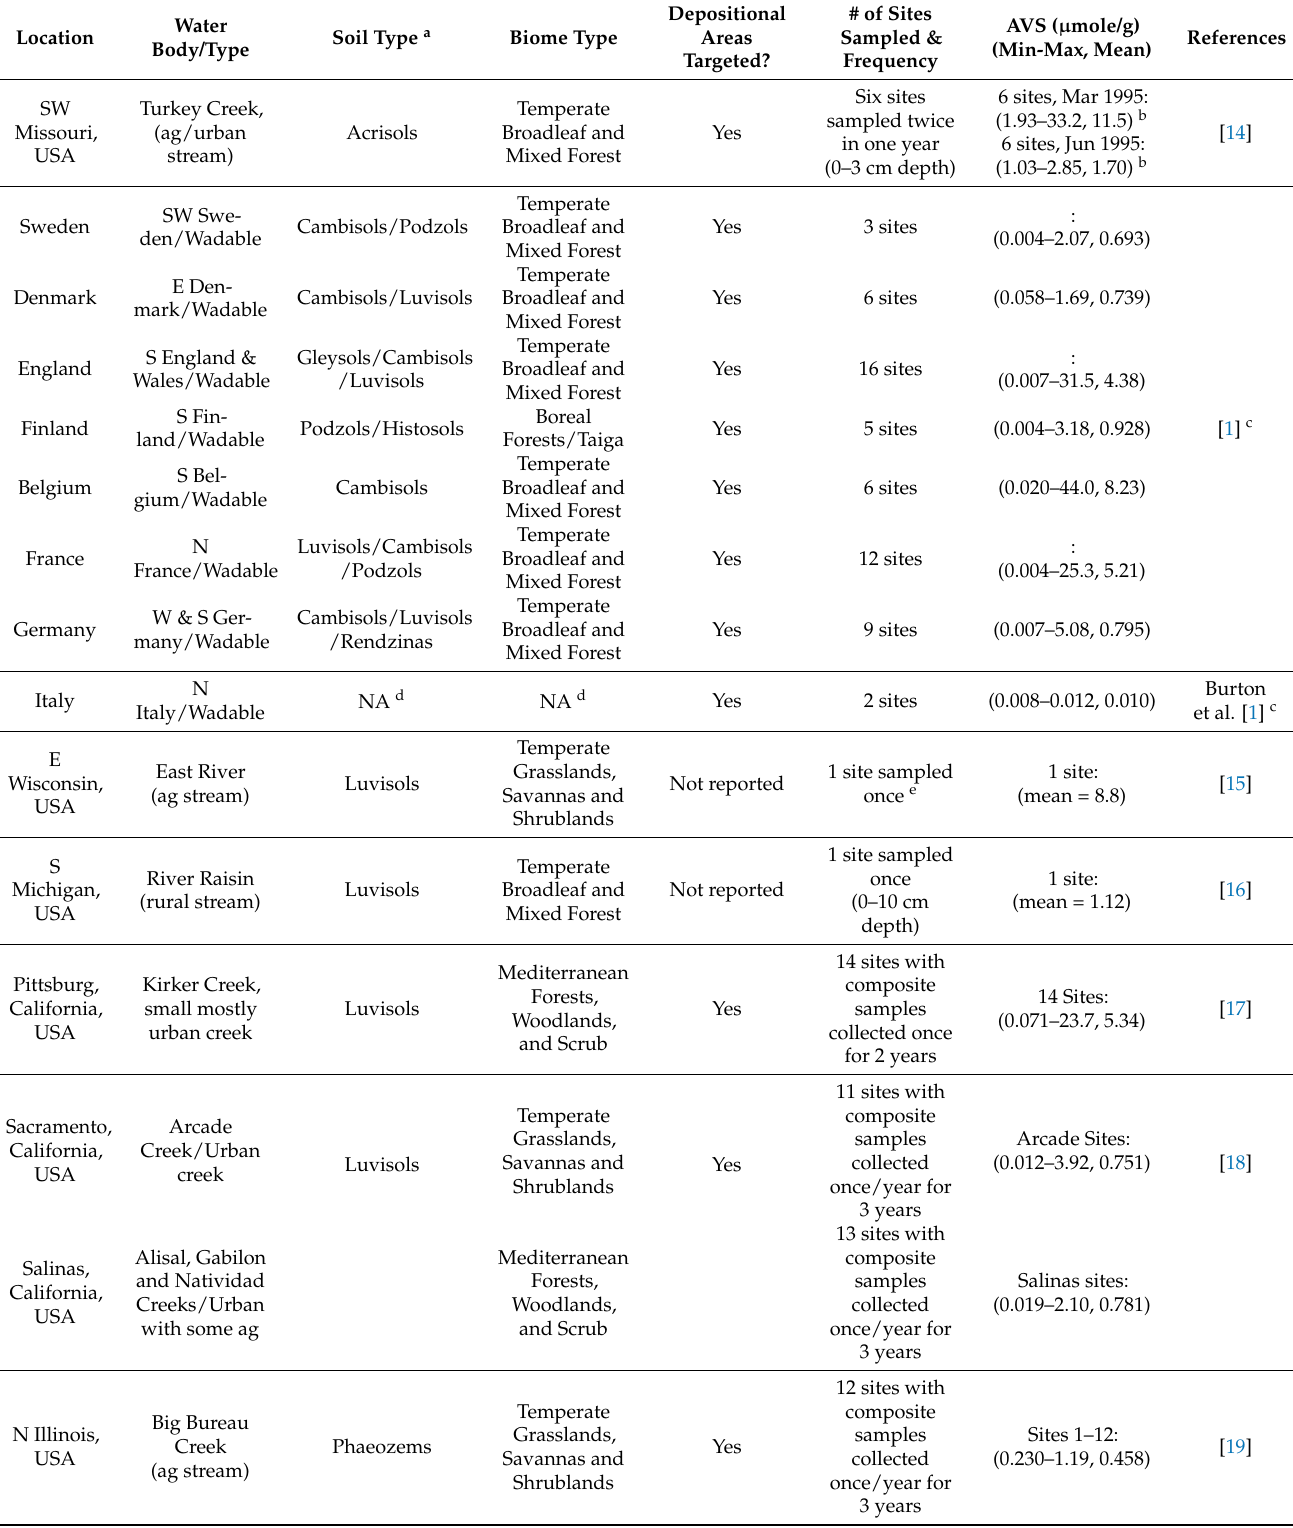
Table 1. Summary of historical acid-volatile sulfides (AVS) sediment data from streams and